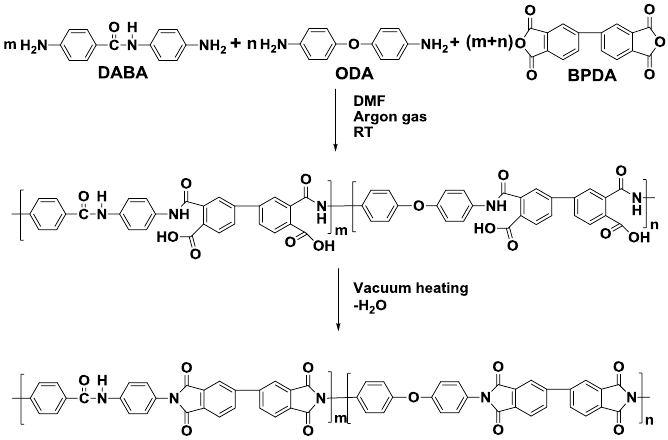
Scheme 1. Scheme of the synthesis of polyimide containing amide moieties. BPDA: 3,3 (cid:48) ,4,4 (cid:48) -